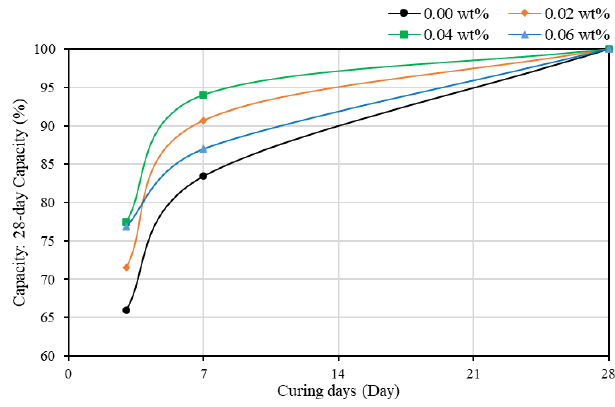
Figure 3. The evolution of the strength of mortars (no TX10) as a function of curing time.